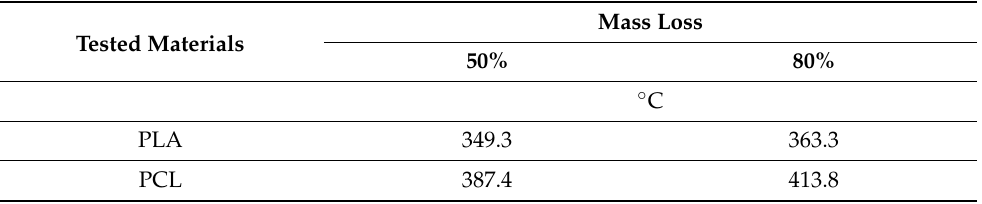
Table 1. Thermal stability estimators for the investigated biopolymer samples. Tested